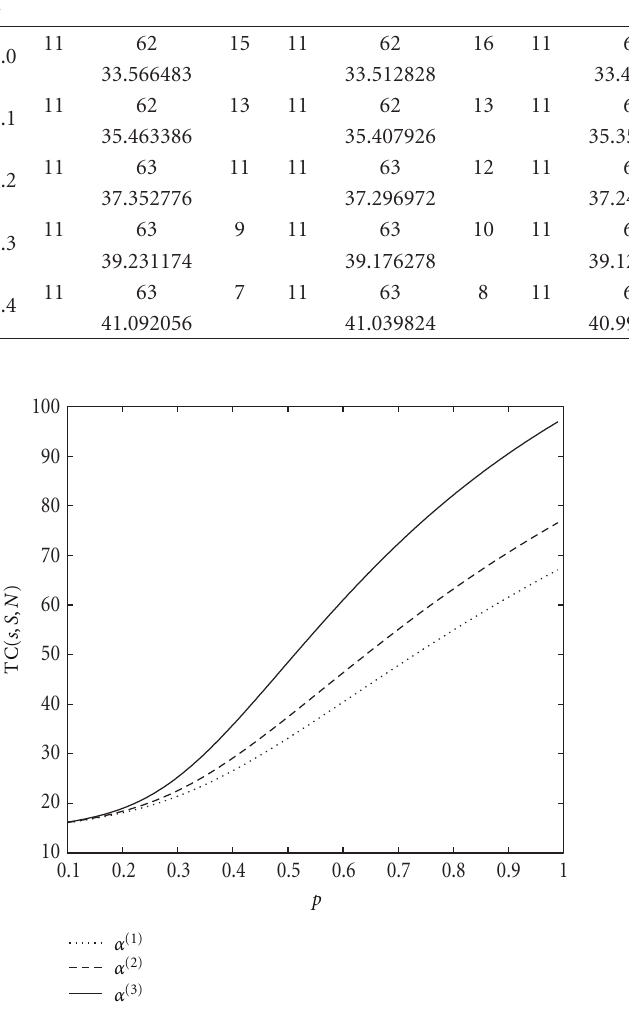
Figure 6: The total expected cost rate— p versus α ( n ) ( S = 90, s = 15, N = 25, λ = 8, β = 1 . 4, γ = 0 . 7, λ = 8 . )